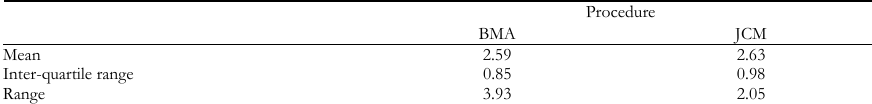
Results of the empirical study: descriptive statistics of RMSE values for 39 test